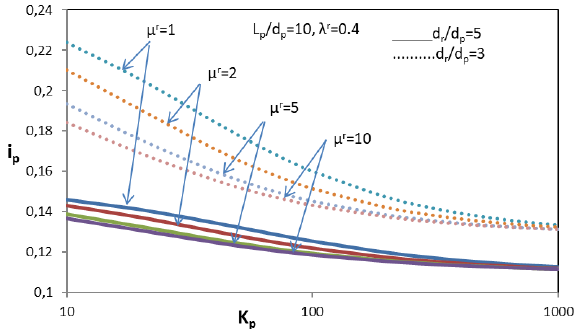
, considering radial displacement with p , of GP– effect of strengthening p /d , on partially r p /d =10, λ r =0.4). p p